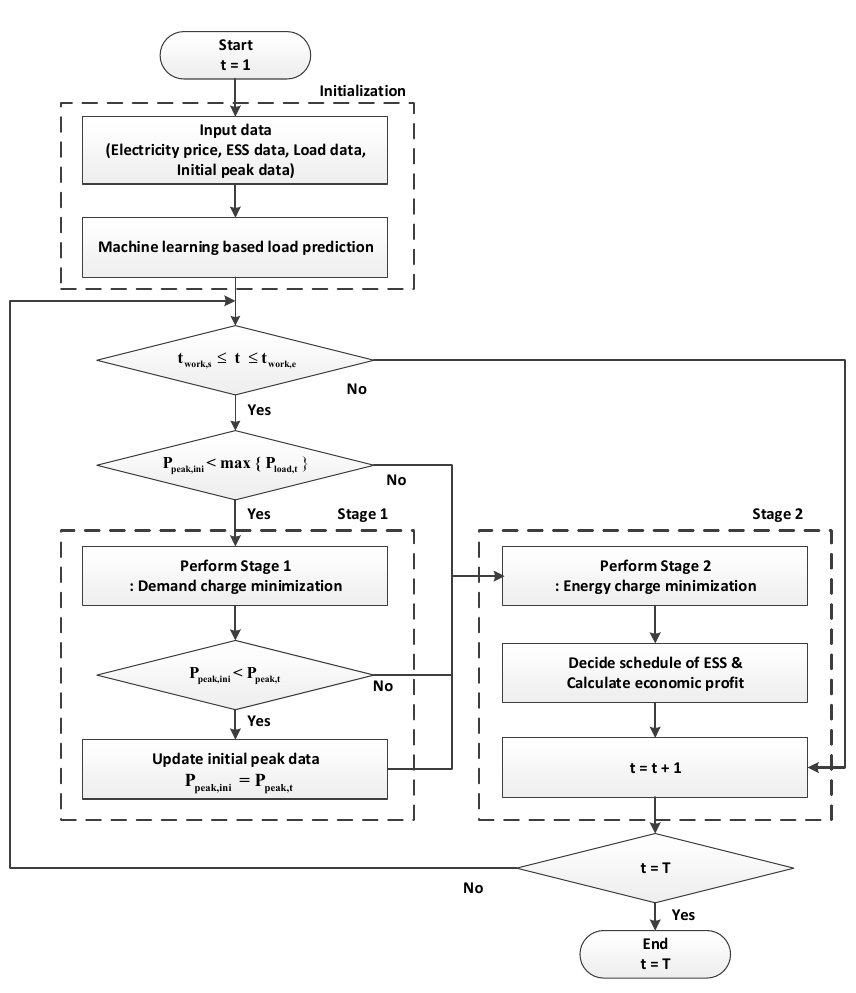
Figure 2. Flow chart of the ESS optimization algorithm.